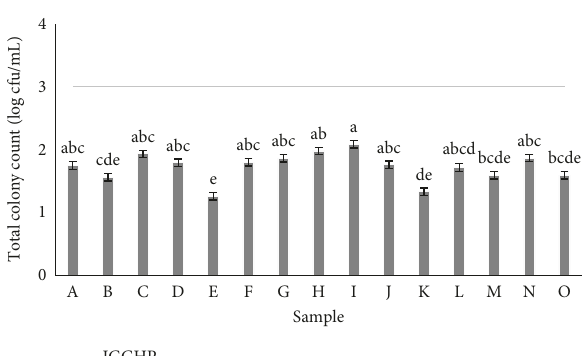
Figure 7: Total colony count at 22 ° C for 15 samples of treated water. A-B: Sg. Ramal ; C-E: Section 8, Bandar Baru Bangi ; F-I: Section 16, Bandar Baru Bangi ; J, K, and O Section 3, Bandar Baru Bangi ; L-N: Section 15, Bandar Baru Bangi . All results are expressed in mean ± SD. a-e Values for the samples which have different letters are significantly different ( p < 0 .